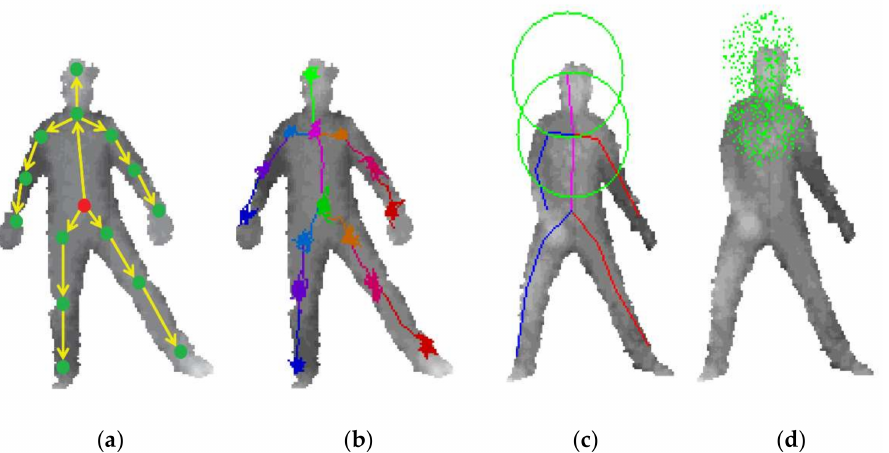
Figure 12. Example of classification tree for human joint estimation. ( a ) illustrates the kinematic tree implemented along with random tree walk (RTW). First, the random walk toward belly positions starts from body center. The belly positions (red dot in ( a )) become starting point for hips and chest, and so forth. ( b ) shows the RTW path examples. ( c ) illustrates offset sample range spheres in green. In ( d ), the green dots represent offset samples. Figure from